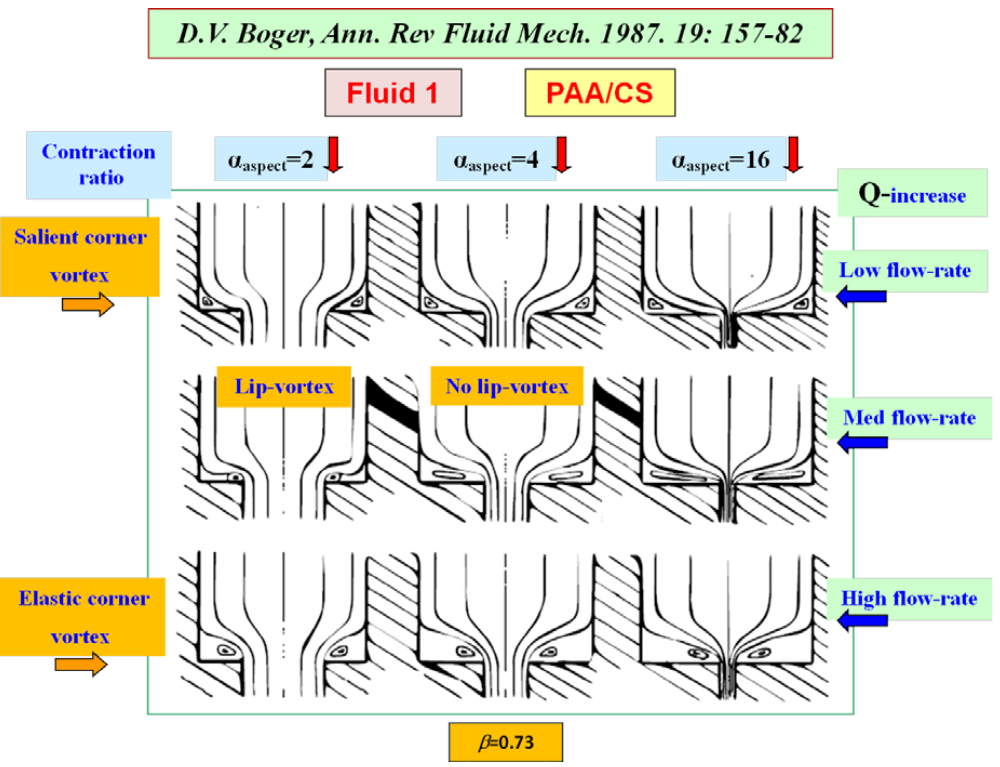
Figure 1. Vortex-activity with increasing flow-rate Q ; Boger Fluid-1 (PAA/CS); β = 0.73, α aspect = {2, 4, Figure1. Vortex-activitywithincreasingflow-rate Q ;BogerFluid-1(PAA / CS); β = 0.73, α aspect = {2, 4, 16}.